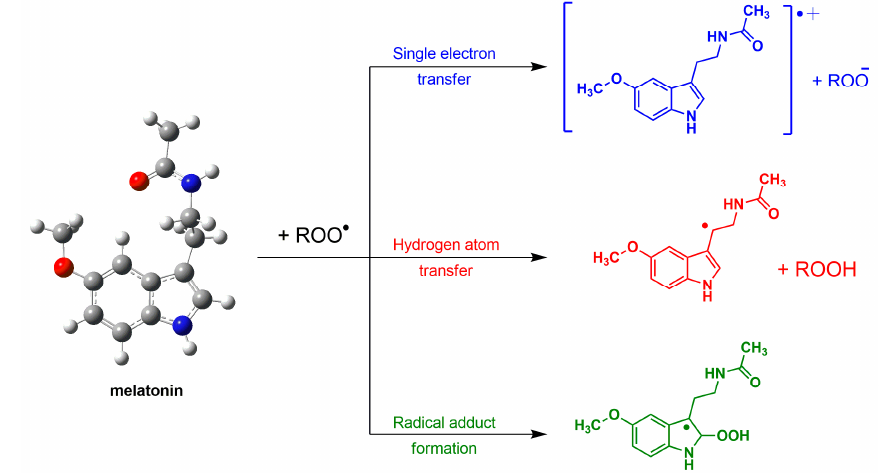
Figure 2. The means by which melatonin detoxifies a lipid peroxyl radical (LOO•) are shown in this figure and include electron transfer, hydrogen ion transfer and radical adduct formation. These are examples of actions of melatonin that are receptor independent. If the free radical was a •OH radical rather than a LOO• radical, because of the very high reactivity of the former, the number of reaction products would be much greater.